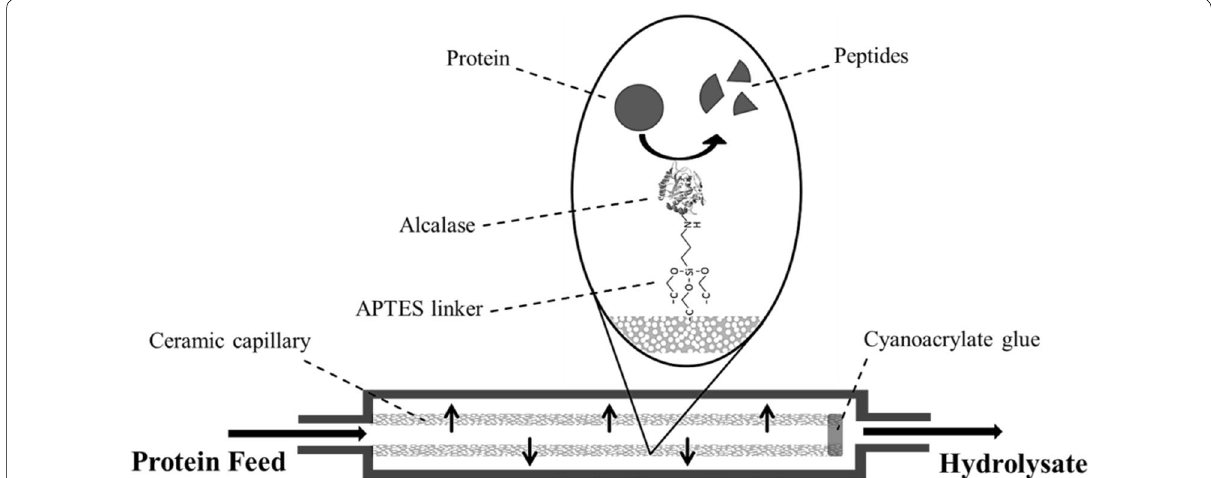
Fig. 1 Capillary module. Enzymes are immobilized onto the APTES functionalized ceramic support to enable a continuous hydrolysis of the